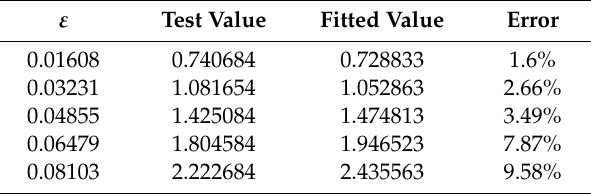
Table 13. The deviation between the test and calculated values for specimen 2 under 400 ◦